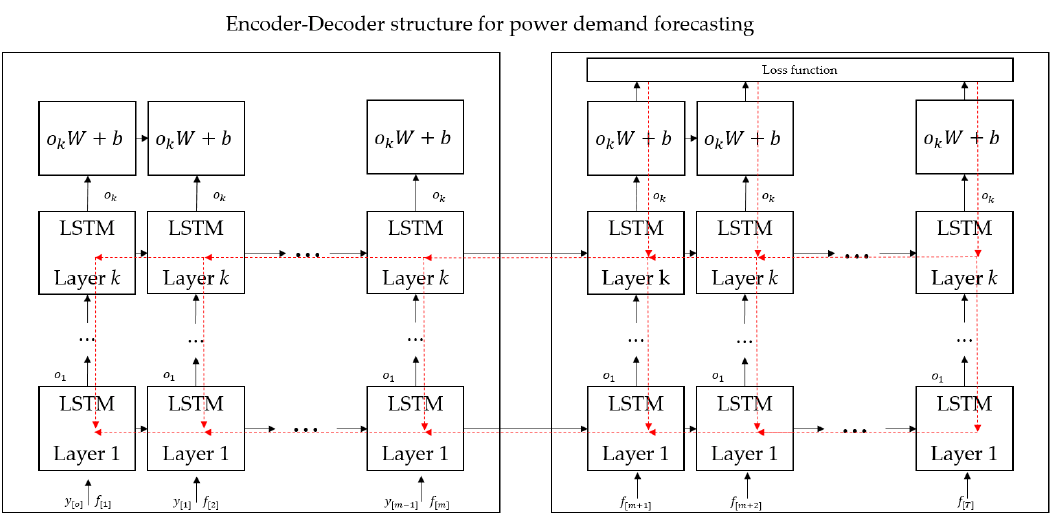
Figure 1. Structure of the S2S model.